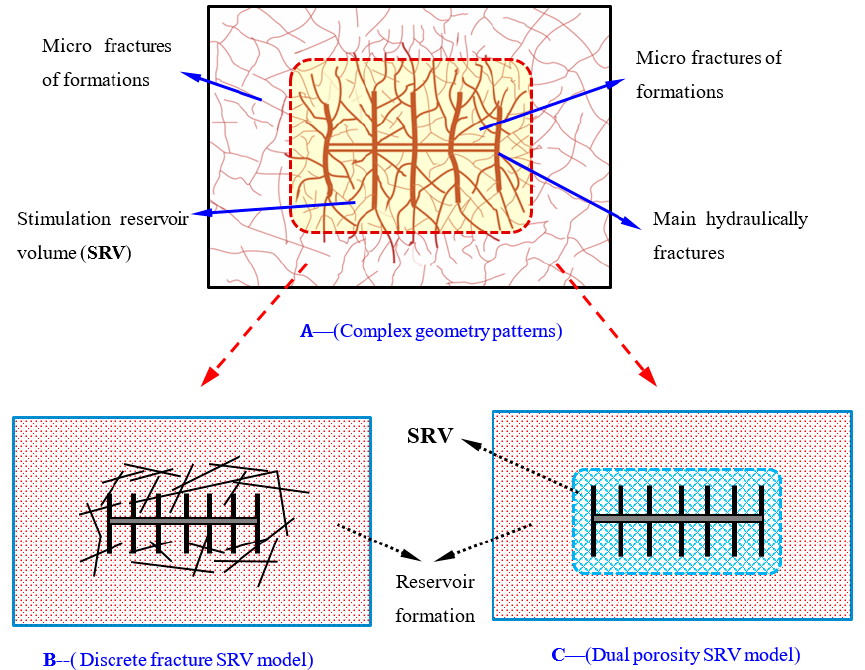
Figure 2. Hydraulic multiple fractured horizontal well with the stimulated reservoir volume (SRV) and its simplified models.